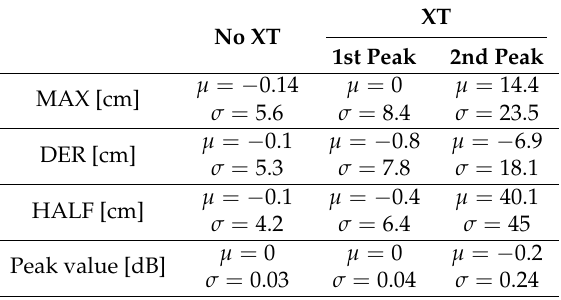
Table 1. Effect of cross-talk in three different delay estimators and in the peak amplitude in the flight over the Bass